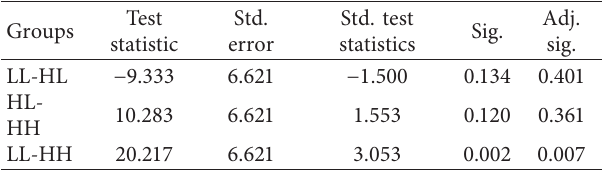
Table 5: Results of the post hoc test for writing